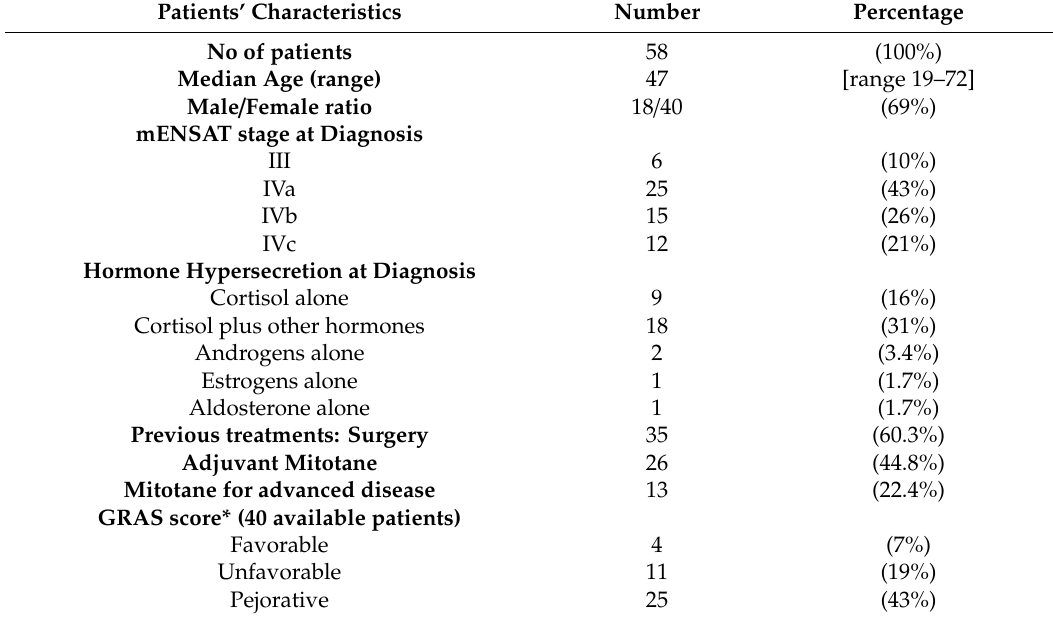
Table 1. Patients’